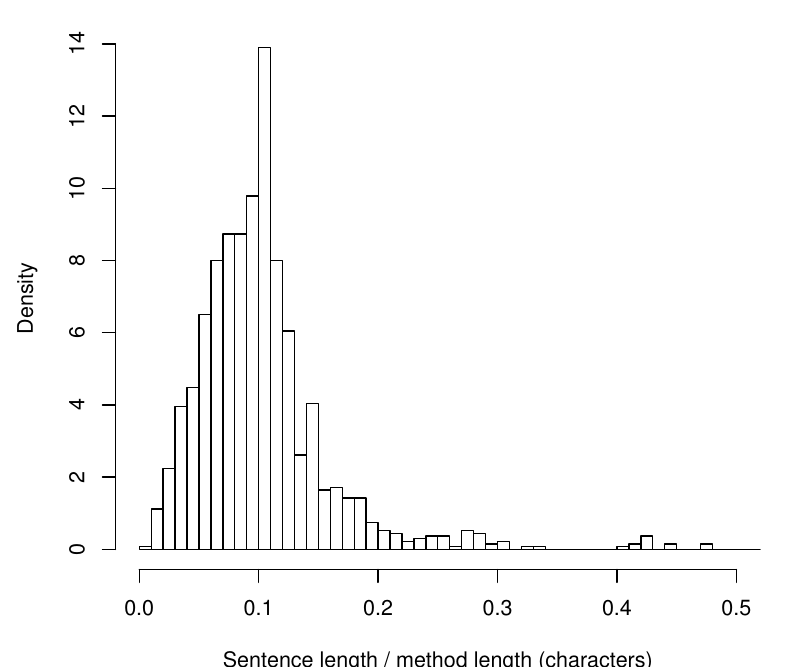
Figure 2. Length of a documentation sentence divided by the length of the method it describes